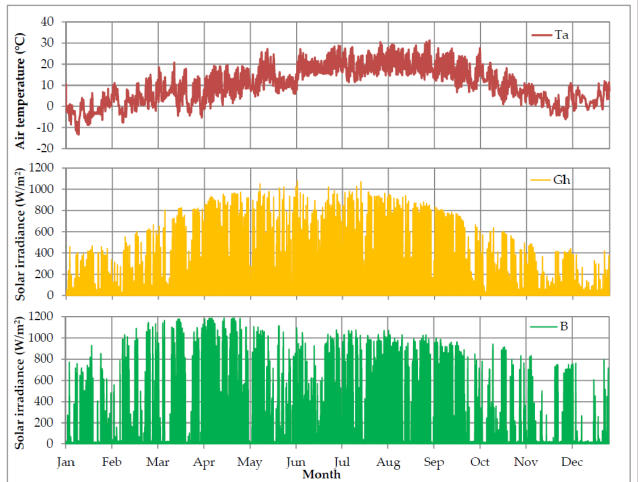
Figure 9. Hourly outdoor air temperature (Ta), global horizontal solar irradiance (Gh) and direct solar irradiance (B) imported in Trnsys17 based on the on-site measured values in Brasov in